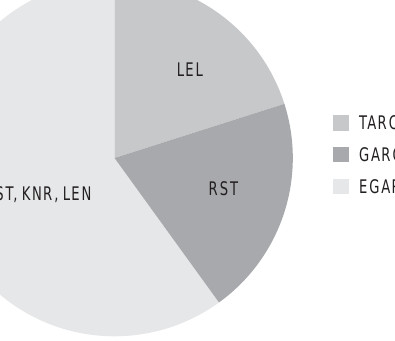
Fig. 2. Financial sector Fig. 3. Consumer Staples